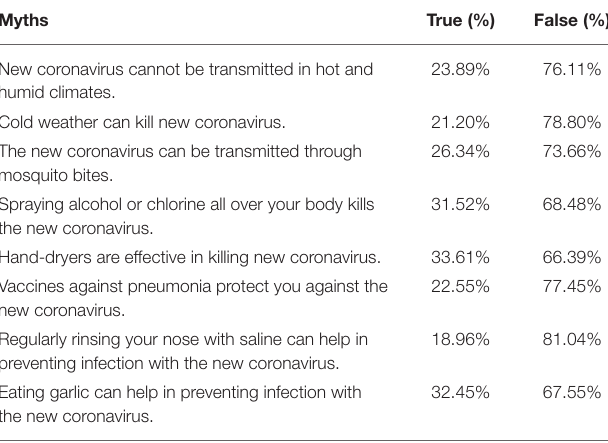
TABLE 5 | Relating frequencies (%) related to COVID-19 preventive measures.